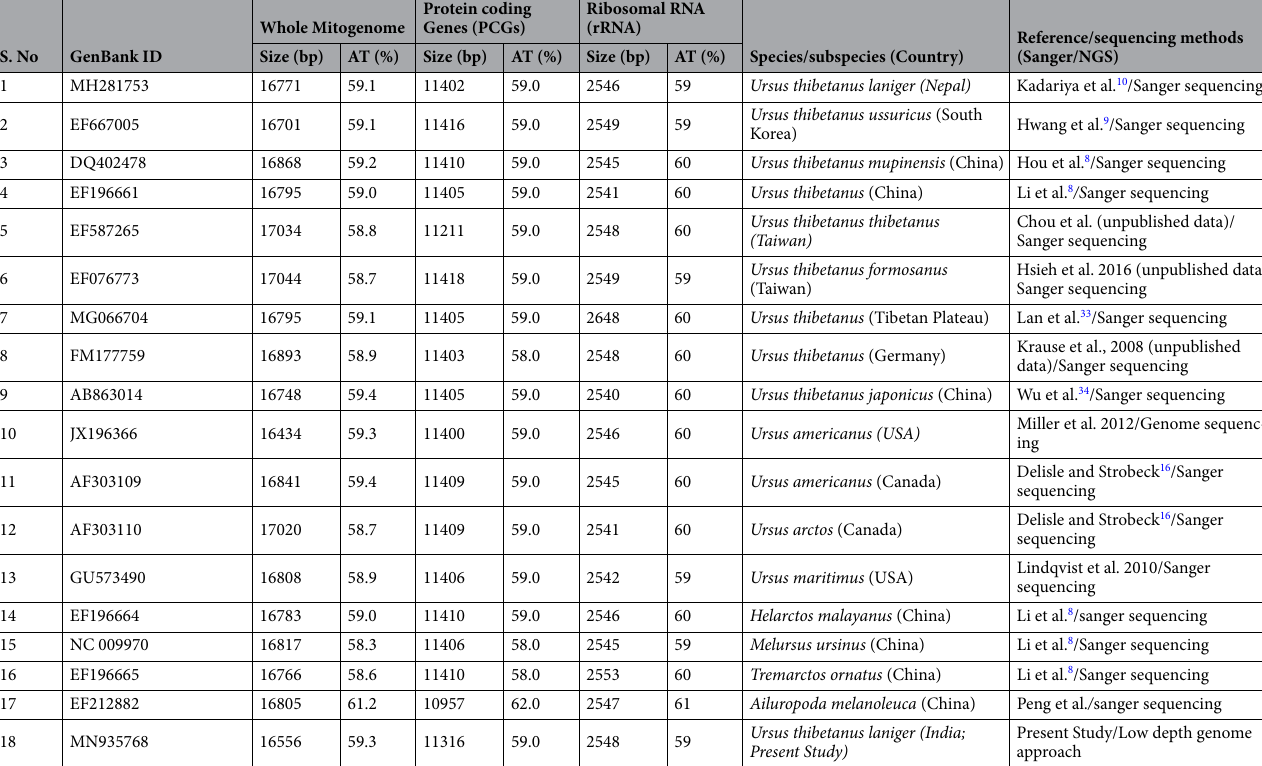
Table 3. Comparative assessment of nucleotide composition indices among different subspecies of Asiatic black bear and other species in the Ursidae